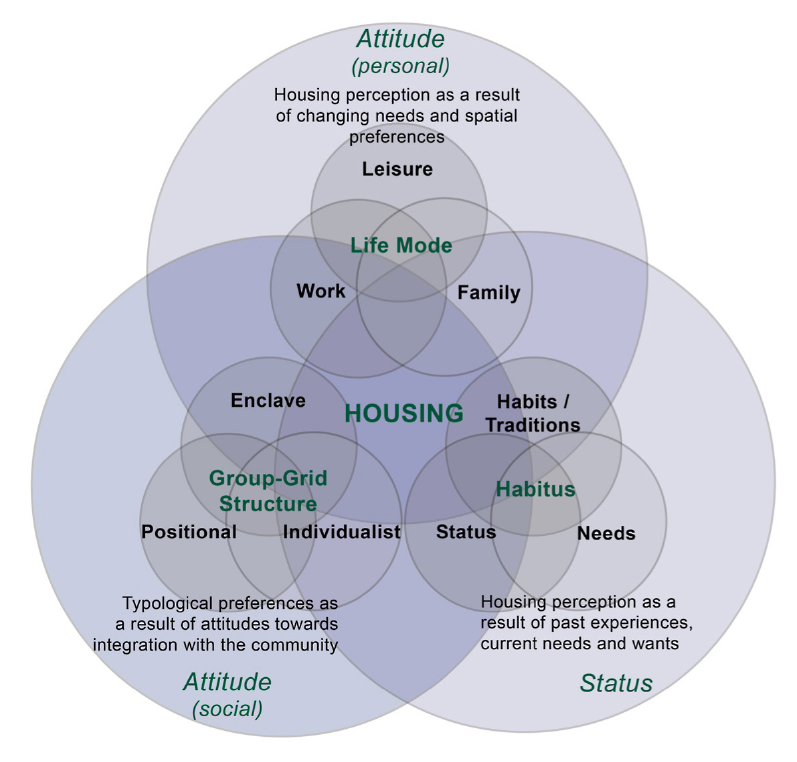
Figure 4. Employing the triadic perspective of lifestyles theories for understanding housing developments, typologies, and choices in four Gulf cities (based on Salama, 2006, 2011; Salama et al.,